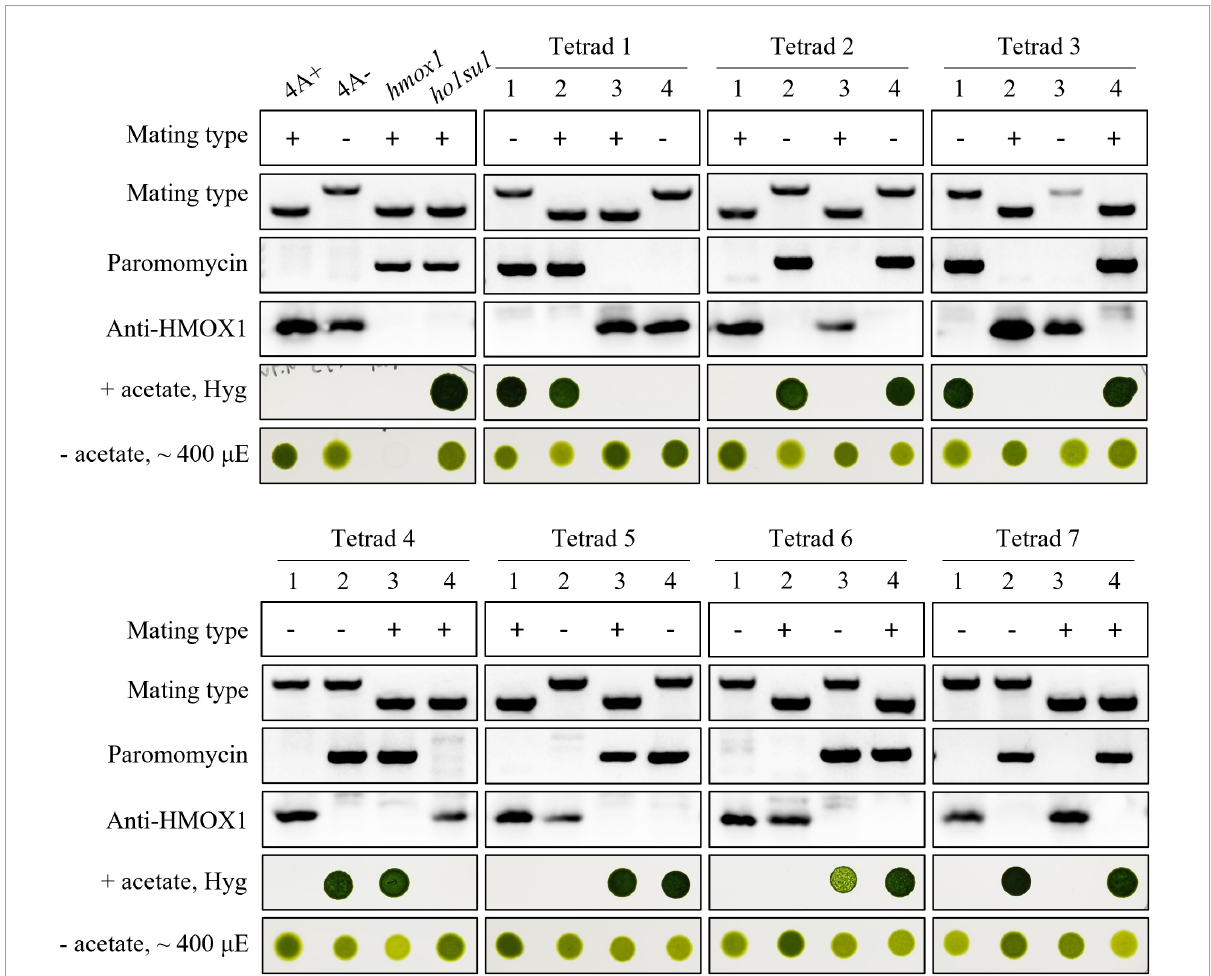
FIGURE2 Genetic analyses of ho1su1 . Progeny from seven complete tetrads derived from crosses between 4A– (mt–) and ho1su1 (mt+) were used for genetic linkage analysis. Mating type, antibiotic resistance against paromomycin and hygromycin (Hyg), accumulation of HMOX1, and photoautotrophic growth (– acetate) in light intensity of approximately 400 µ E were analyzed. PCR amplification of specific DNA fragments was used to test mating type and to test for the presence of the paromomycin resistance gene